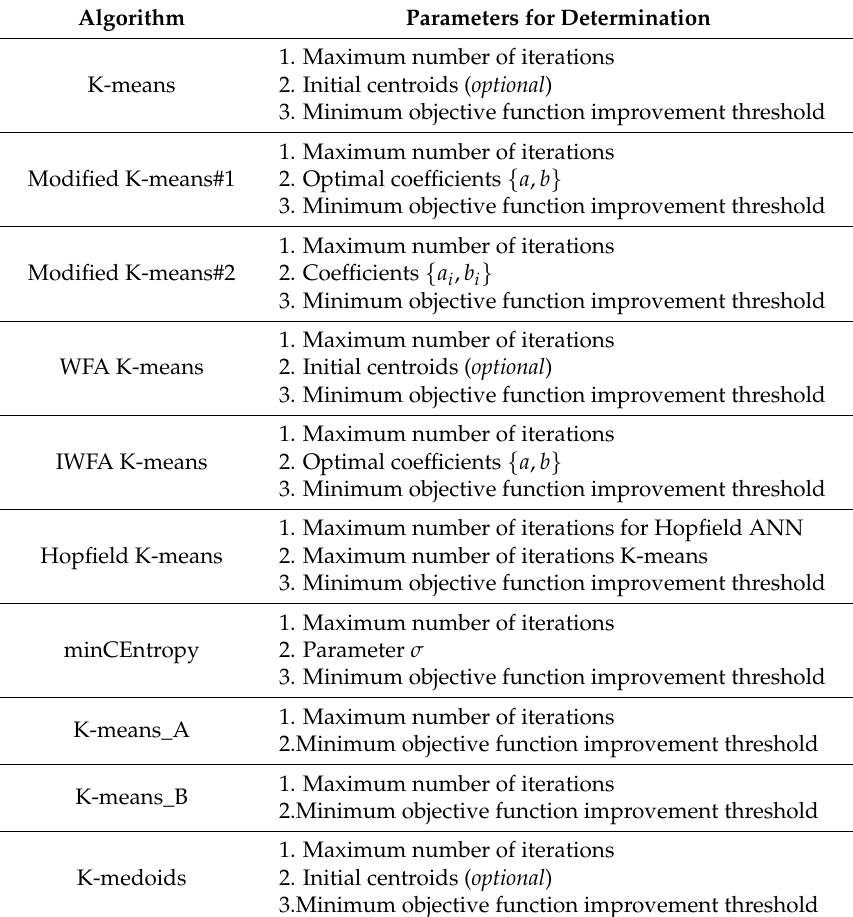
Table 2. Parameters of the partitional algorithms.